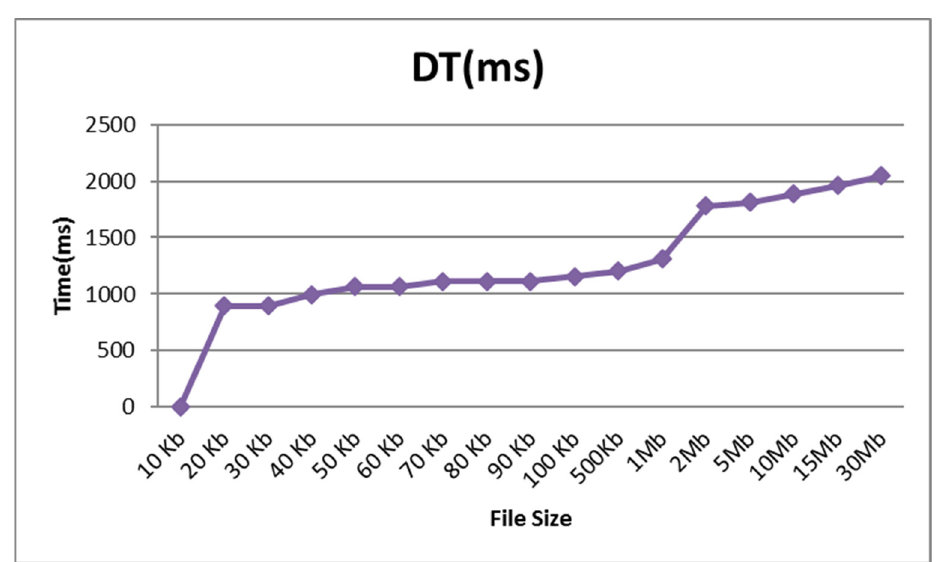
Figure 3. Download time.